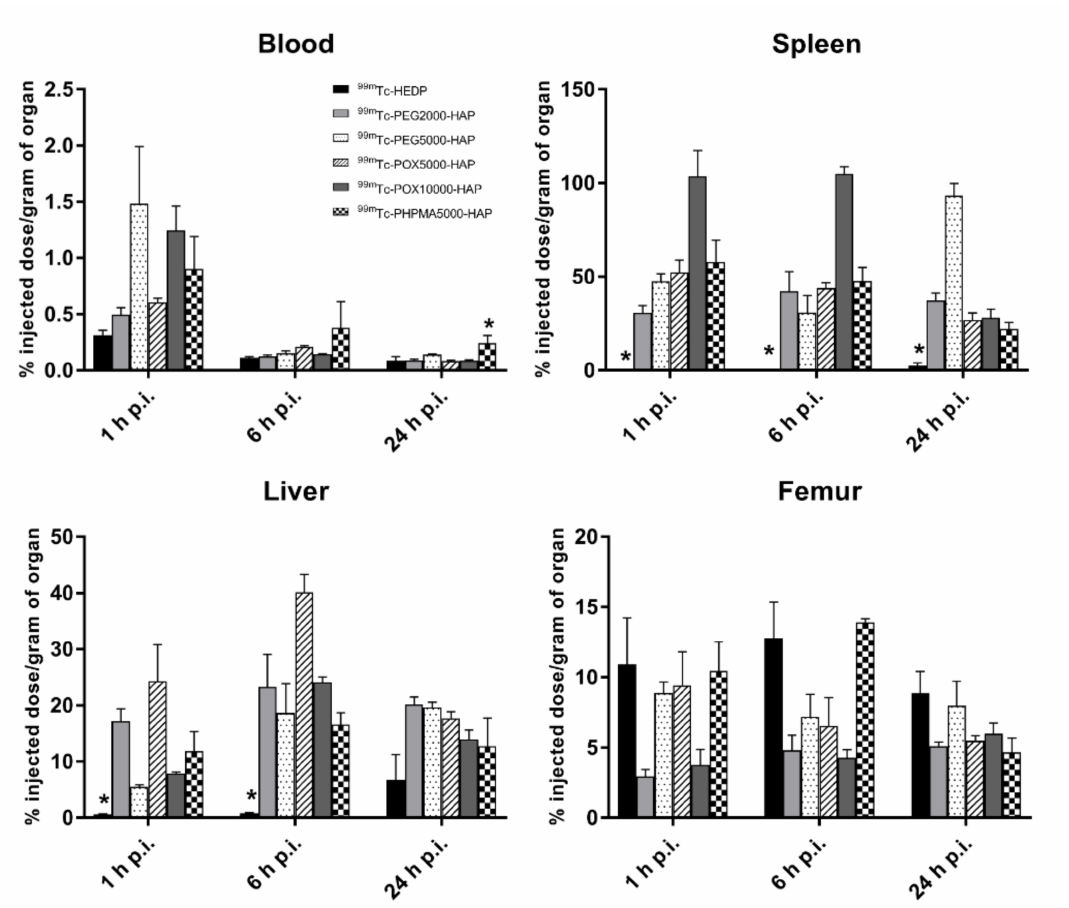
Figure 4. Uptake of 99m Tc-HEDP, 99m Tc-PEG2000-HAP, 99m Tc-PEG5000-HAP, 99m Tc-POX5000-HAP, 99m Tc-POX10000-HAP and 99m Tc-PHPMA5000-HAP NPs in blood, spleen, liver and femur of healthy Balb / c mice 1, 6 and 24 h p.i. ( n = 3 animals per time point); * indicates statistical di ff erence ( p < 0.05). Biodistribution of 99m Tc-HEDP labeled HAP NPs in tumor xenograft model (Figure 5) revealed